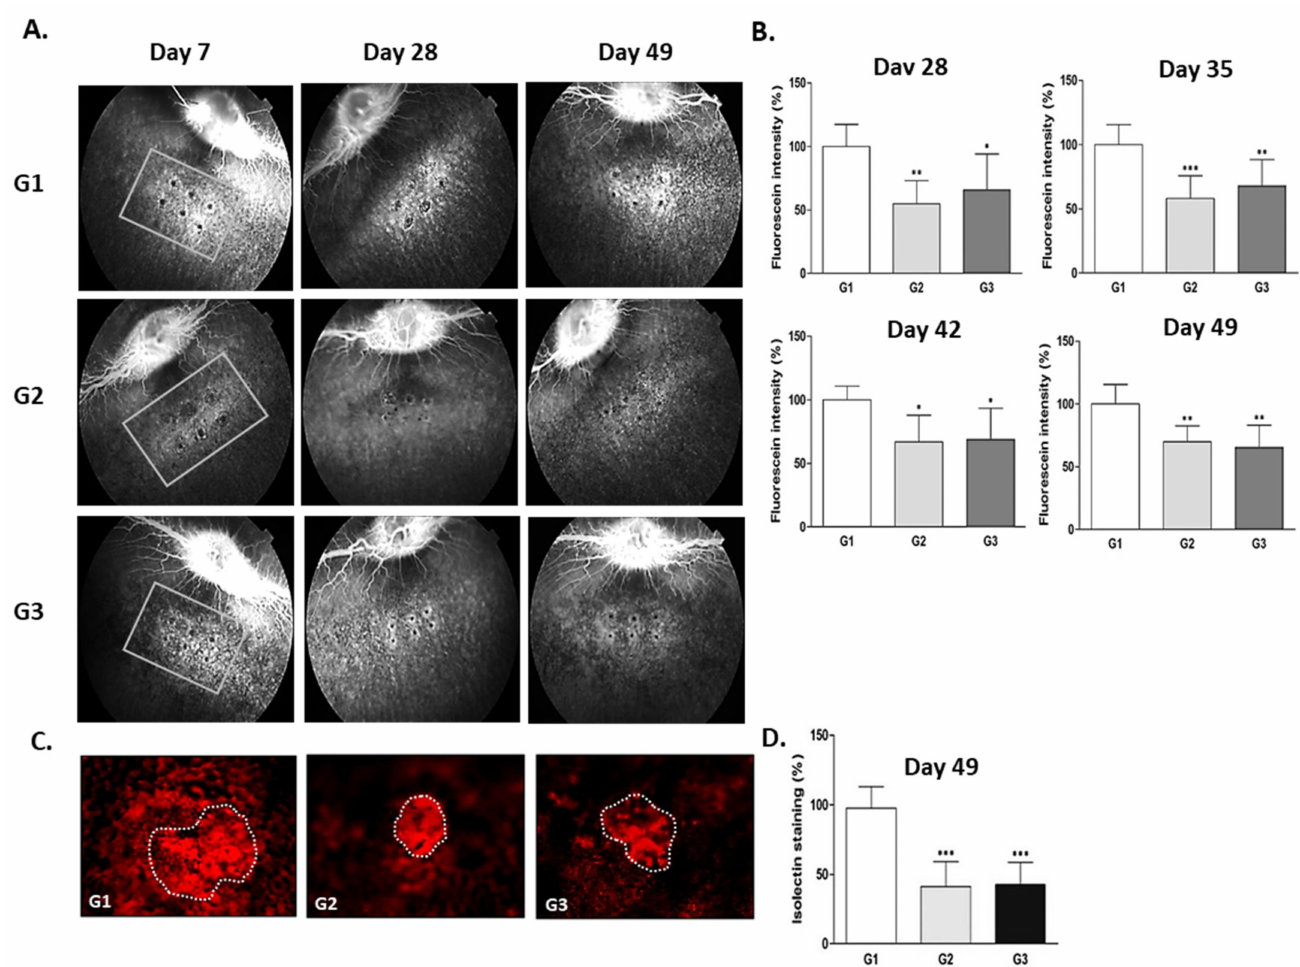
Figure 7. The therapeutic efficacies of the intravitreal administration of Ac-RLYE and aflibercept on choroidal neovascular- ization (CNV) in laser-induced CNV rabbit models with treatment of peptide or aflibercept 1 week after laser irradiation to induce active CNV for 1 week. The intensity of laser irradiation and spot size was empirically set in order to maintain the retinal fluorescence intensity in the vehicle treatment group at 7 weeks after laser irradiation. ( A ): Representative retinal fluorescence fundus image. ( B ): A quantitative image analysis result for retinal fluorescence intensity using the ImageJ software. ( C ): Representative fundus photography of retinal angiography (parts shown by a dotted line represent the boundary of a choroidal neovascularization membrane) analyzed by fluorescence microscope at Day 49 after laser induced CNV (Day 42 from the test substance treatment). ( D ): A quantitative image analysis result for the area of CNV using the ImageJ software. The day of laser irradiation was designated as day 0. Data are expressed as mean ± S.D. G1: Vehicle control, G2: Ac-RLYE 100 µ g/50 µ L/eye, G3: Aflibercept 2000 µ g/50 µ L/eye ( n = 7 rabbits per group). ***/**/* A significant difference at p < 0.001/ p < 0.01/ p < 0.05 level compared to the G1. Compared to retinal fluorescence intensity observed in vehicle group (arbitrarily set at 100%, G1), the intravitreal administration of Ac-RLYE (G2) and aflibercept (G3) significantly reduced fluorescence